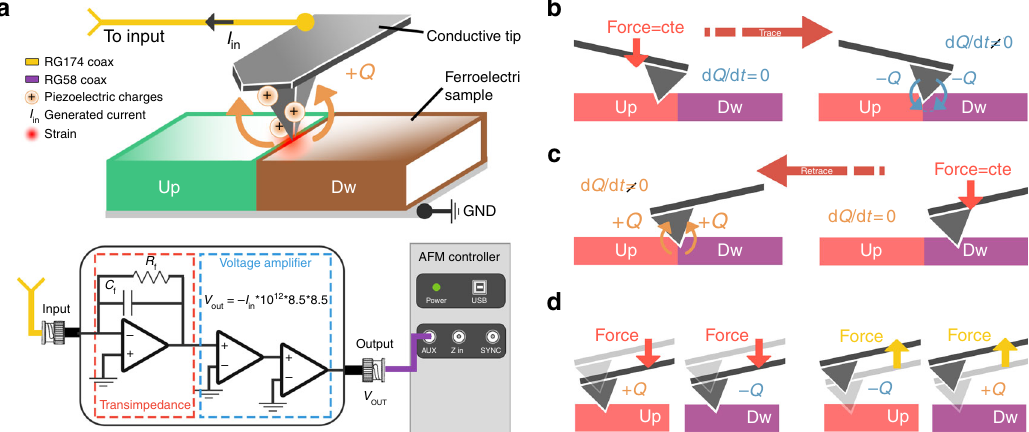
Fig. 1 Schematic of the measurement set-up and explanation of the proposed experiments. a Set-up used to record the piezoelectric charge generated by the material through the use of a special current-to-voltage transimpedance ampli fi er. The ampli fi er maintains a reasonable bandwidth of 4 – 5 Hz with an ultralow input-bias current consumption of < 0.1 fA. b When a single domain polarization is scanned, there is no current fl owing, as the force is kept constant. However, when the tip crosses different domains, there will be a current fl owing as the force is kept constant, but the d 33 value will invert its sign. c At the domain wall, the generated current can be modeled as the tip will enter into one domain, loading it, and will leave an opposite domain, unloading it. The sign of charge generation depends on the scan direction or more precisely on whether the tip crosses from and Up to a Down domain (generation of Q < 0) or from an Down to an Up domain (generation of Q > 0). d Spectroscopy sweep model obtained when the tip performs a force-vs-distance sweep. While the tip exerts a force on the sample a strain is created. Once the force is released, unstraining occurs. The straining and unstraining